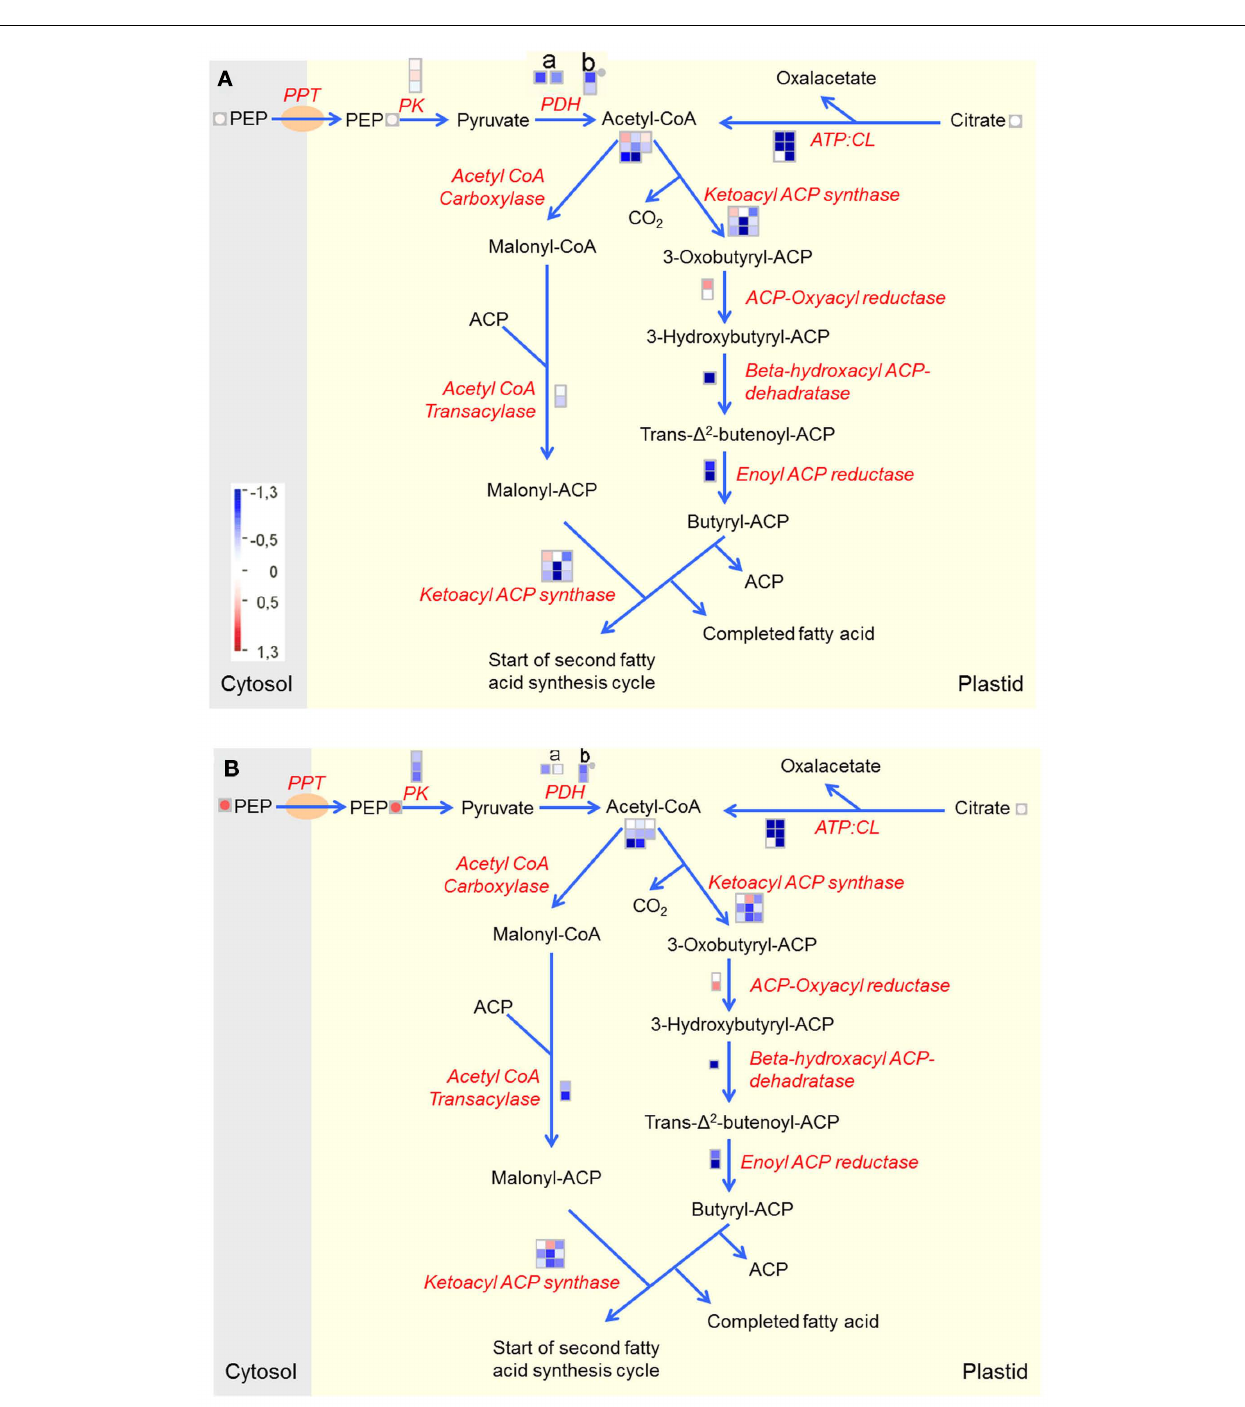
also serves as an inhibitor of fructokinase activity, a possible rea- son for slightly reduced expression of fructokinase 2 in U-IN-2. A third isoform present in potato tubers, fructokinase 3, which